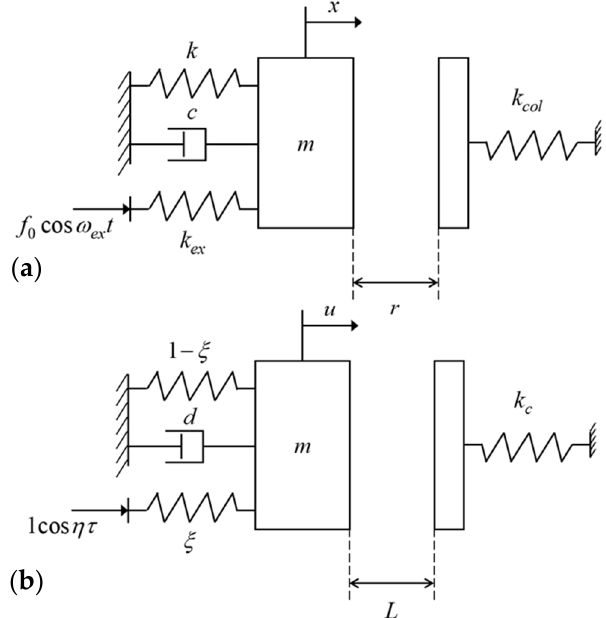
Figure 1. Dynamical impact system with external excitation, ( a ) 1-D impacting oscillator, ( b ) dimensionless form of ( a ).